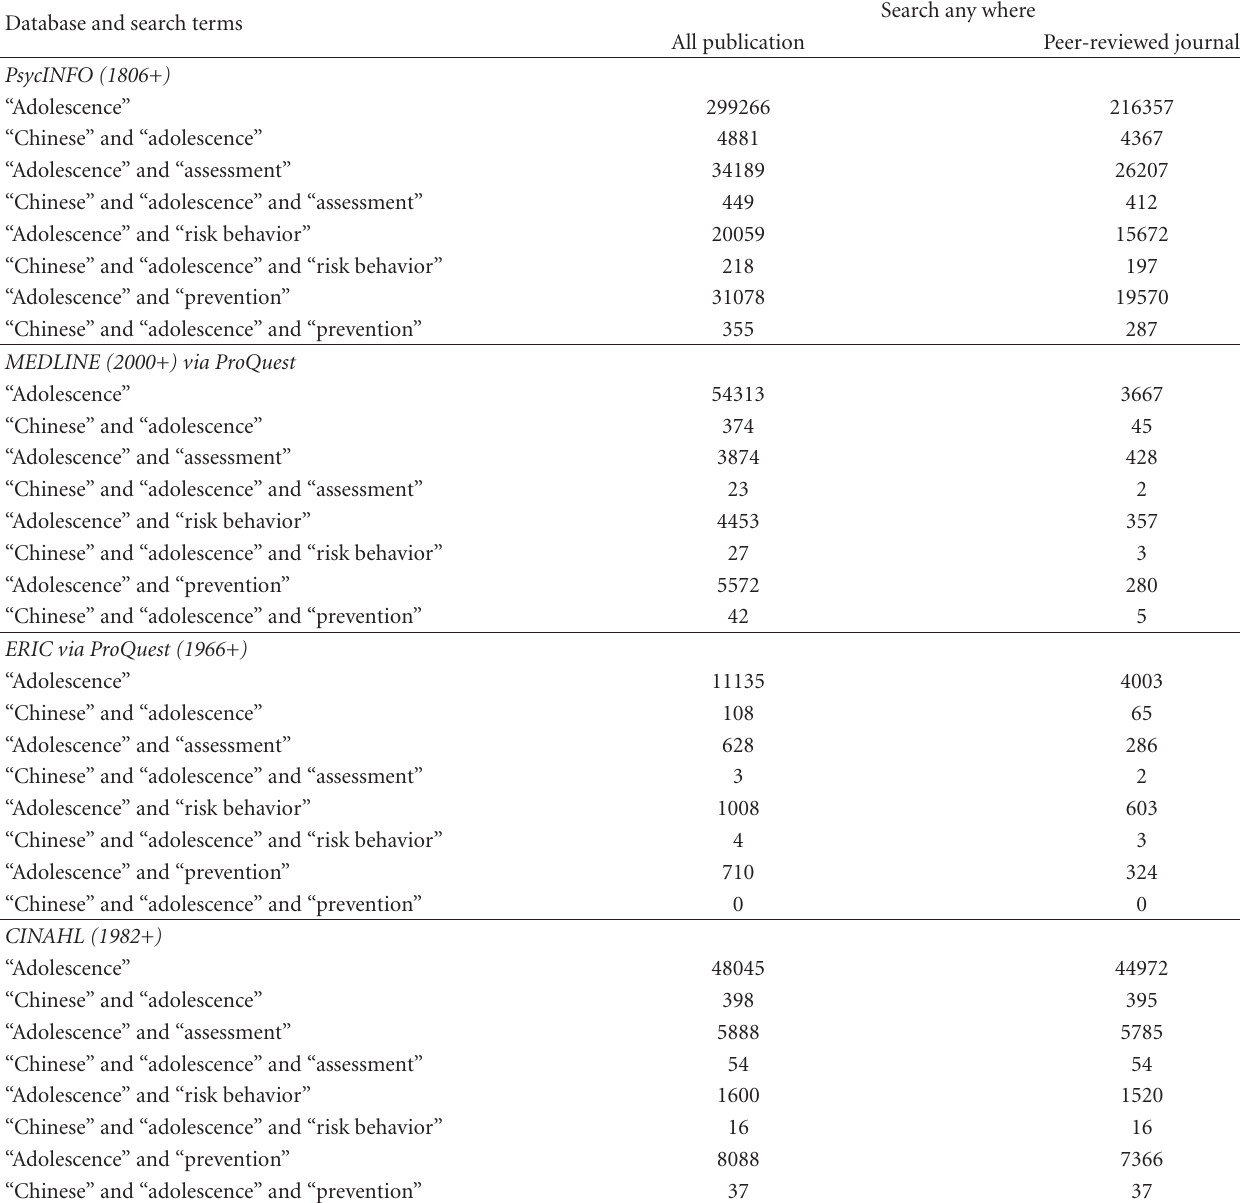
Table 1: Literature search results based on major